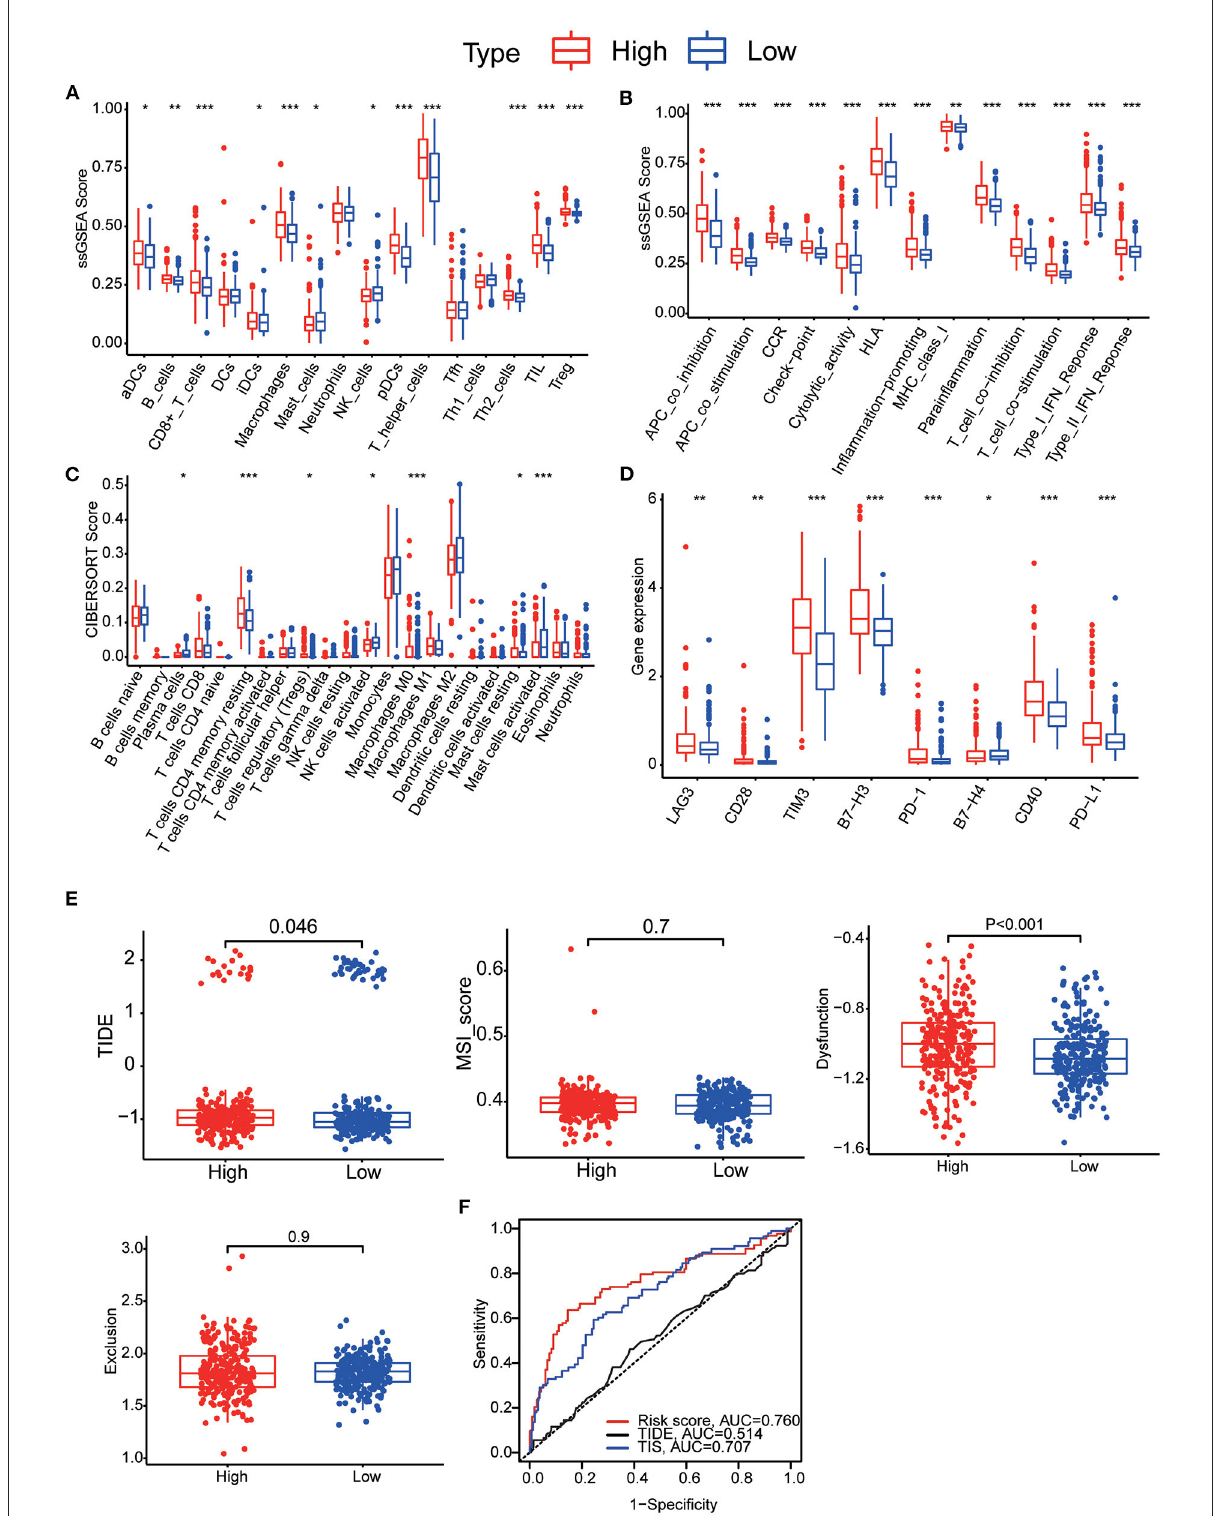
FIGURE8 (A) Boxplots illustrating the 16 immune cells in the two groups using ssGSEA analysis. (B) Boxplots illustrating the 13 immune-linked functions in two groups using ssGSEA analysis. (C) Boxplots illustrating the level of 12 immune cells infiltration in two groups using CIBERSORT analysis. (D) Boxplots illustrating the expression of immune check point genes in high- and low-risk groups. (E) TIDE, MSI and T cell dysfunction and exclusion score in two groups. The variables between the two groups were compared through the Wilcoxon test, * p < 0.05, ** p < 0.01, *** p < 0.001. (F) Time-dependent ROC was used to compare the prediction performance of three prognostic models (our MTRGs related risk score, TIDE,